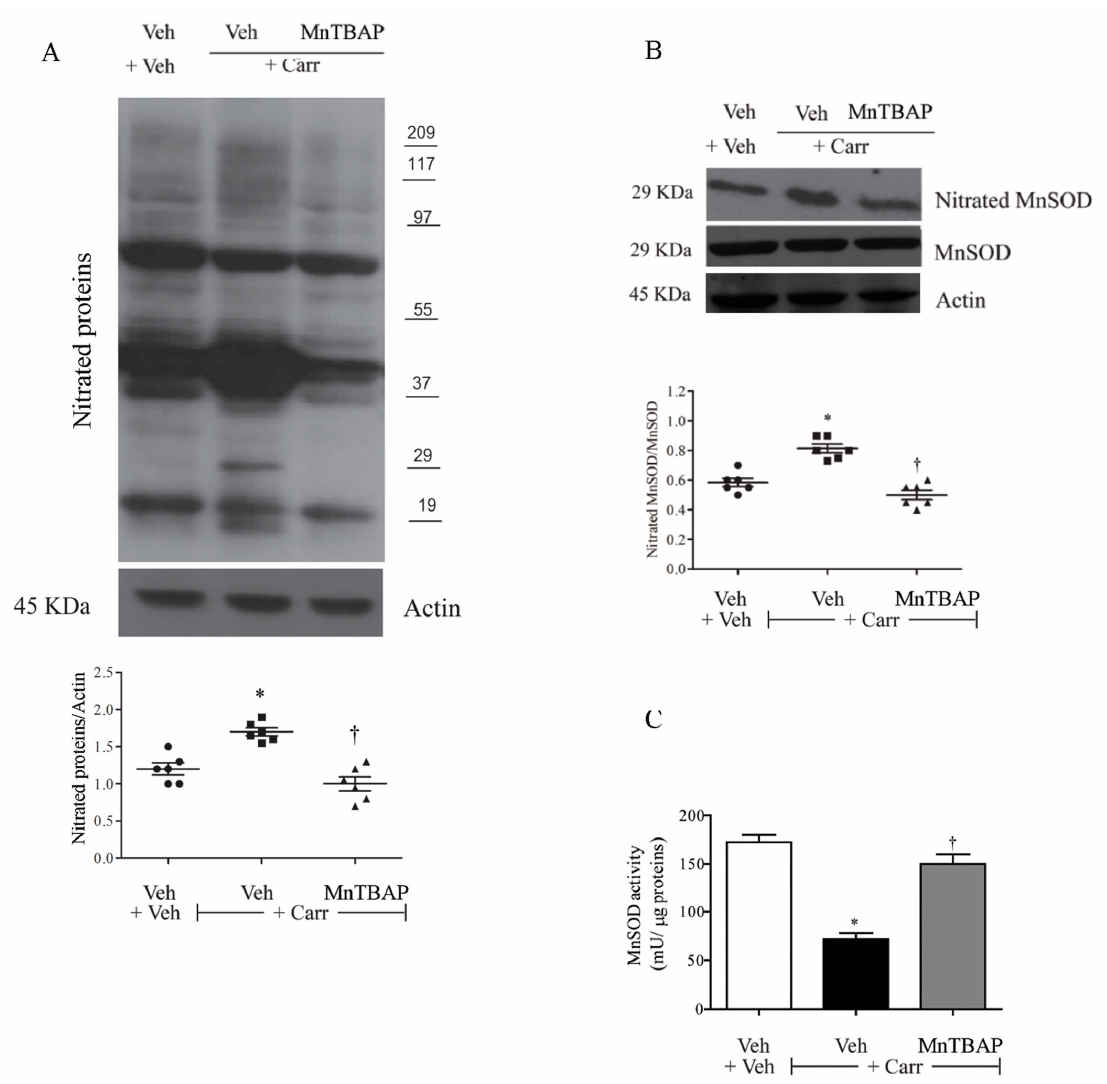
Figure 3. ( A , B ) When compared with the vehicle (Veh) group, animals with carrageenan showed nitration of total proteins, including manganese superoxide dismutase (MnSOD). ( C ) Nitration of MnSOD was linked to the deactivation of MnSOD’s enzymatic function. Compared with the vehicle group, animals that received a carrageenan injection showed lower levels of MnSOD activity in the paws. ( A – C ) Pretreatment with MnTBAP (10 mg / kg) restored the total proteins and MnSOD nitration and its activity in carrageenan-inflamed rats. No di ff erence in MnSOD or β -actin expression was detected among the lanes in these conditions. The gels are representative of results from six animals, and the histogram represents densitometric analyses of all animals per group. Results are expressed as mean ± SEM for six rats. * p < 0.001 compared to Veh + Veh; † p < 0.001 compared to Veh +